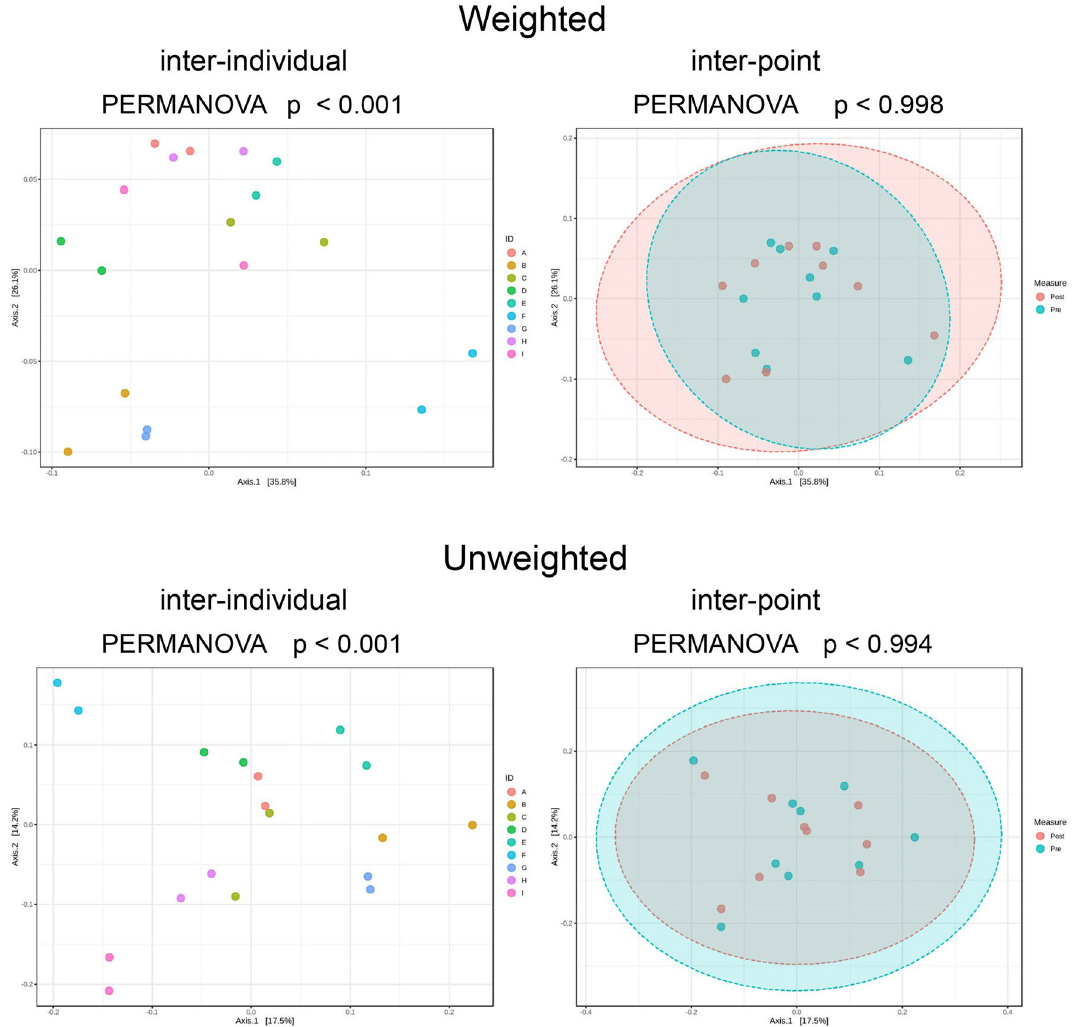
Figure 1. Comparison of β-diversity. Significant interindividual differences were observed in both weighted (p < 0.001) and unweighted (p < 0.001) PCoA, whereas no differences were observed before (Pre) and after (Post) the race.